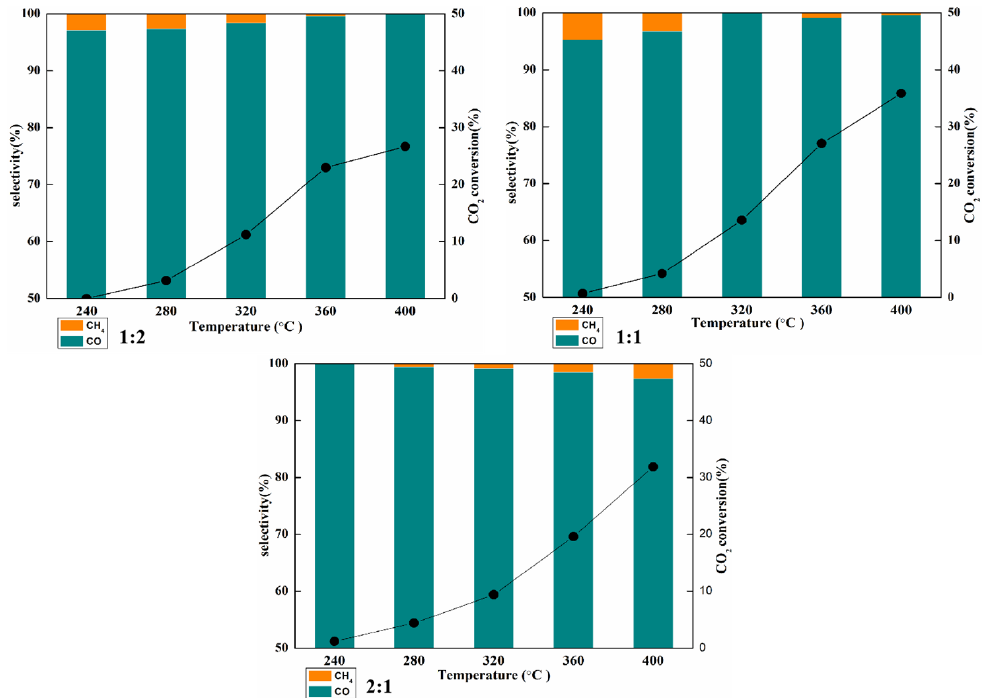
Figure 7. CO 2 conversion, CO selectivity, and CH 4 selectivity for Cu/MoO x catalysts in the RWGS process as a function of temperature.